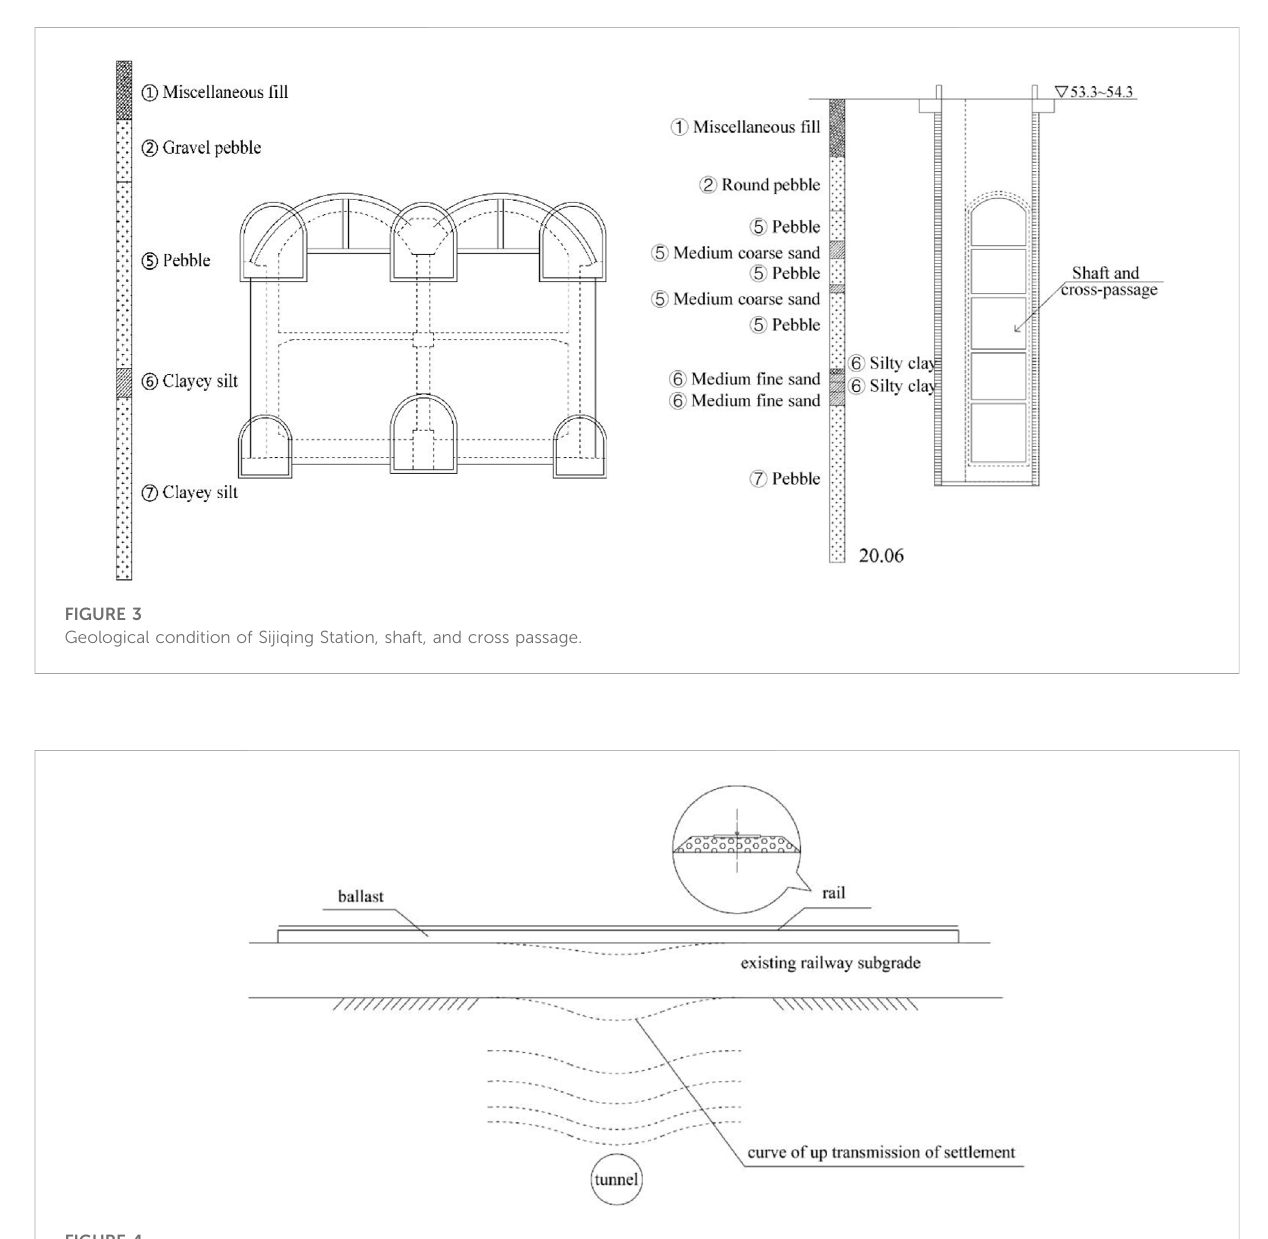
FIGURE 4 Ground deformation transfer path during tunnel excavation under-passing railway line.